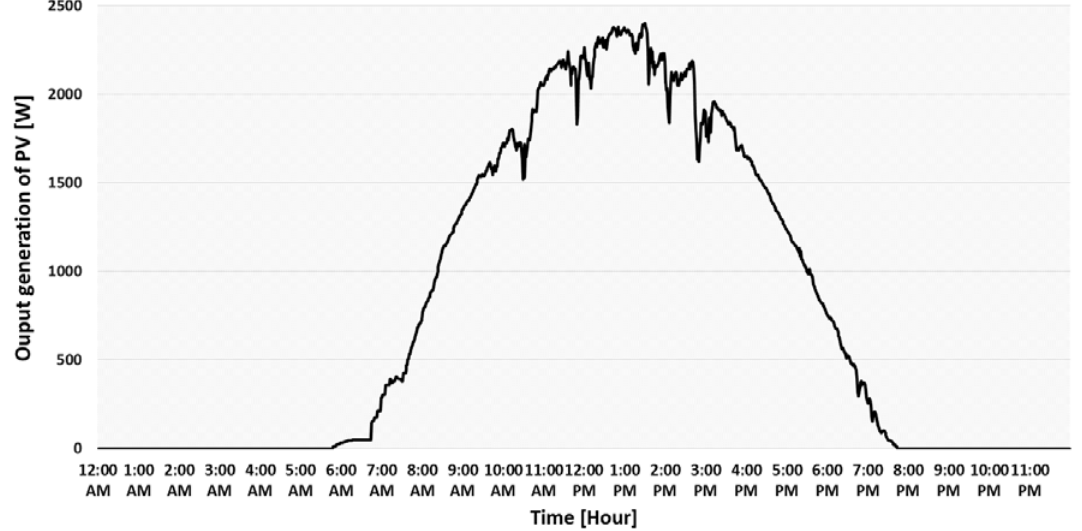
Figure 9. Output generation of a PV on a house (2.5-kW PV).